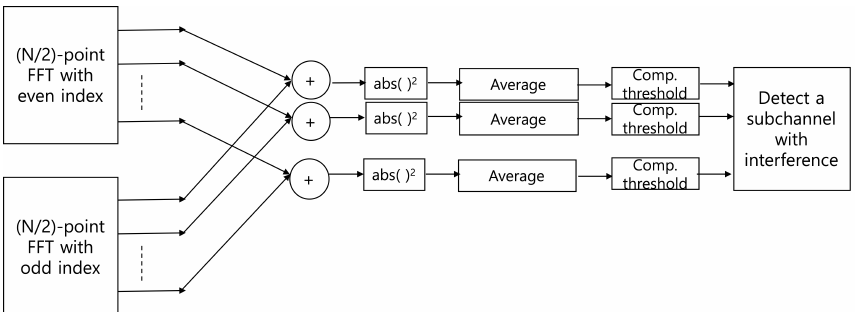
Figure 7. Detailed structure of the continuous wave (CW) tone interference detection block in Figure 6 where N =